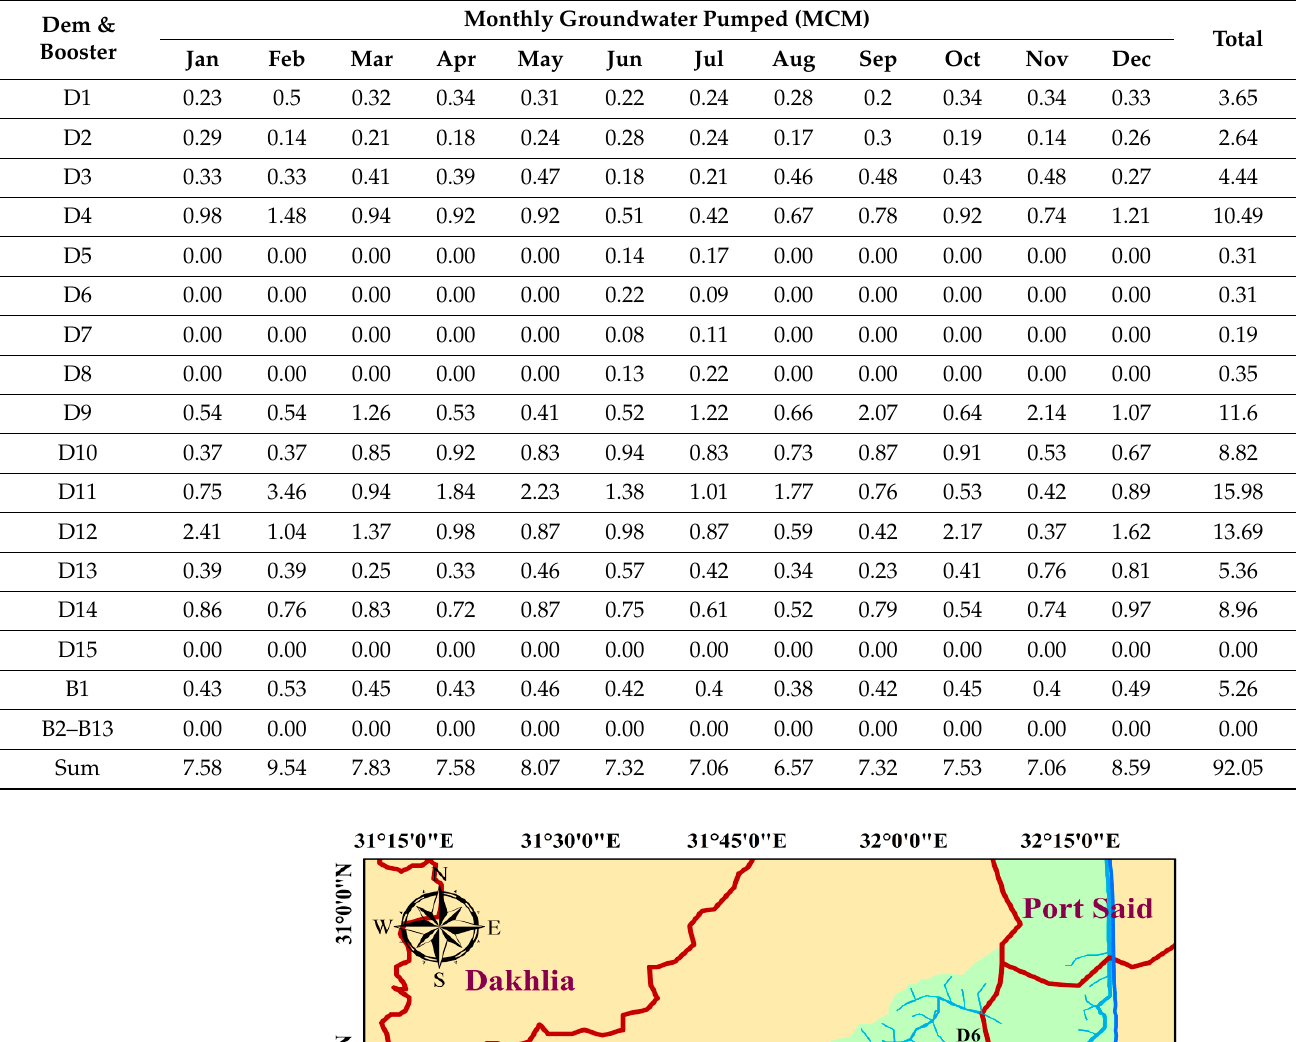
Table 9. Monthly groundwater pumped to study area (MCM).